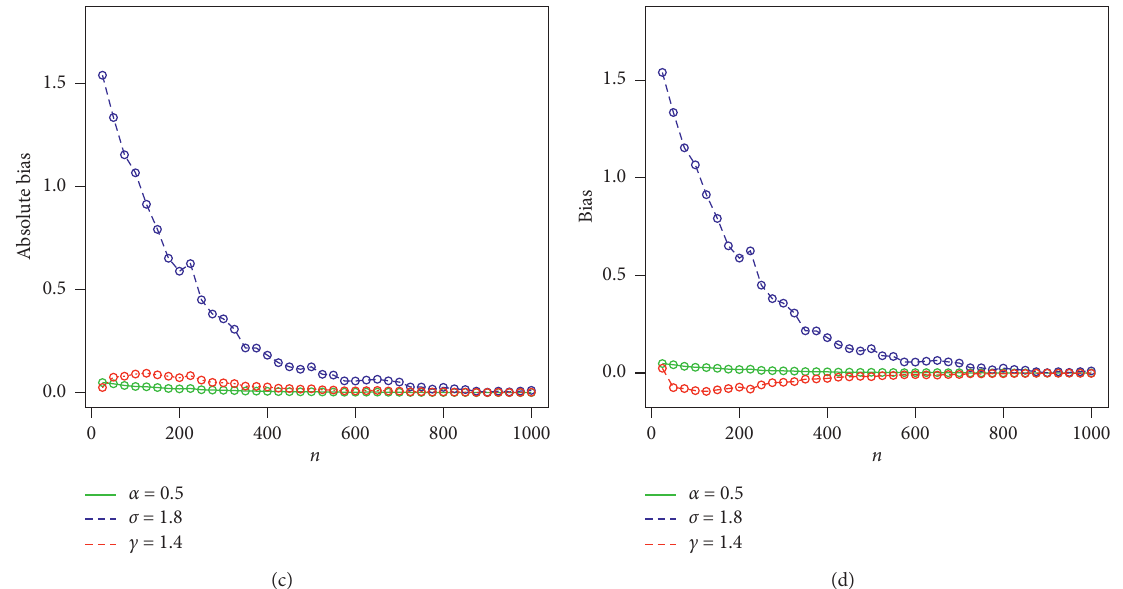
Figure 5: Plots of the estimated parameters, MSEs, absolute biases, and biases for α � 0 . 5, σ � 1 . 8 � , and c � 1 . 4. (a) Plot of estimated parameters versus n . (b) Plot of MSE versus n . (c) Plot of absolute bias versus n . (d) Plot of bias versus n